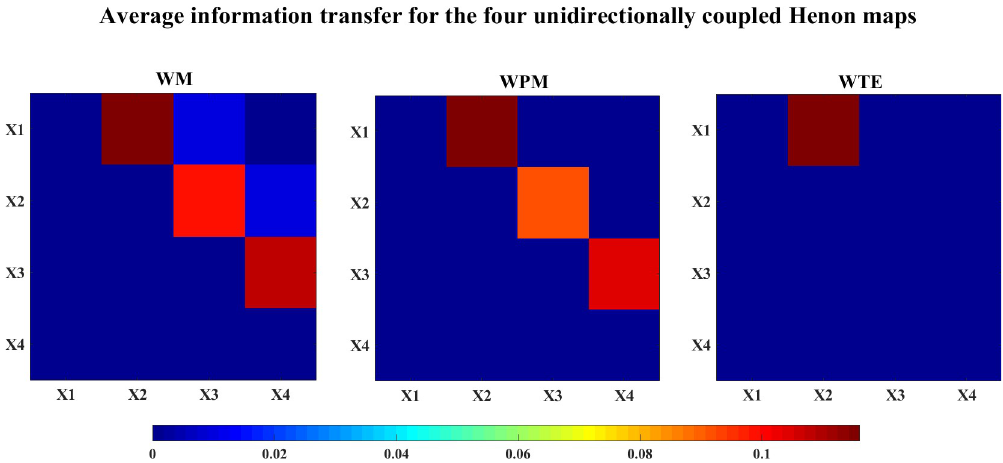
Fig 9. The color-map for the average information transfer between the four unidirectionally coupled Henon maps. The three color-graphs separately show the average WM (left), WPM (middle) and WTE (right) information transfer for the four unidirectionally coupled Henon maps. The direction of each lattice is read from the row channel to the column channel. In this figure, WM indicates all correct interactions from Xi − > Xj where i < j, WPM indicates only the direct directions Xi − > Xi +1,i = 1,2,3, while WTE indicates only X1- > X2 and other directions are failed to be detected.